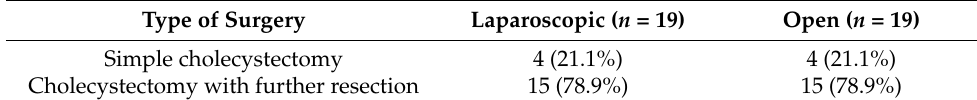
Table 4. Comparison of surgery type in the propensity-score-matched patients.